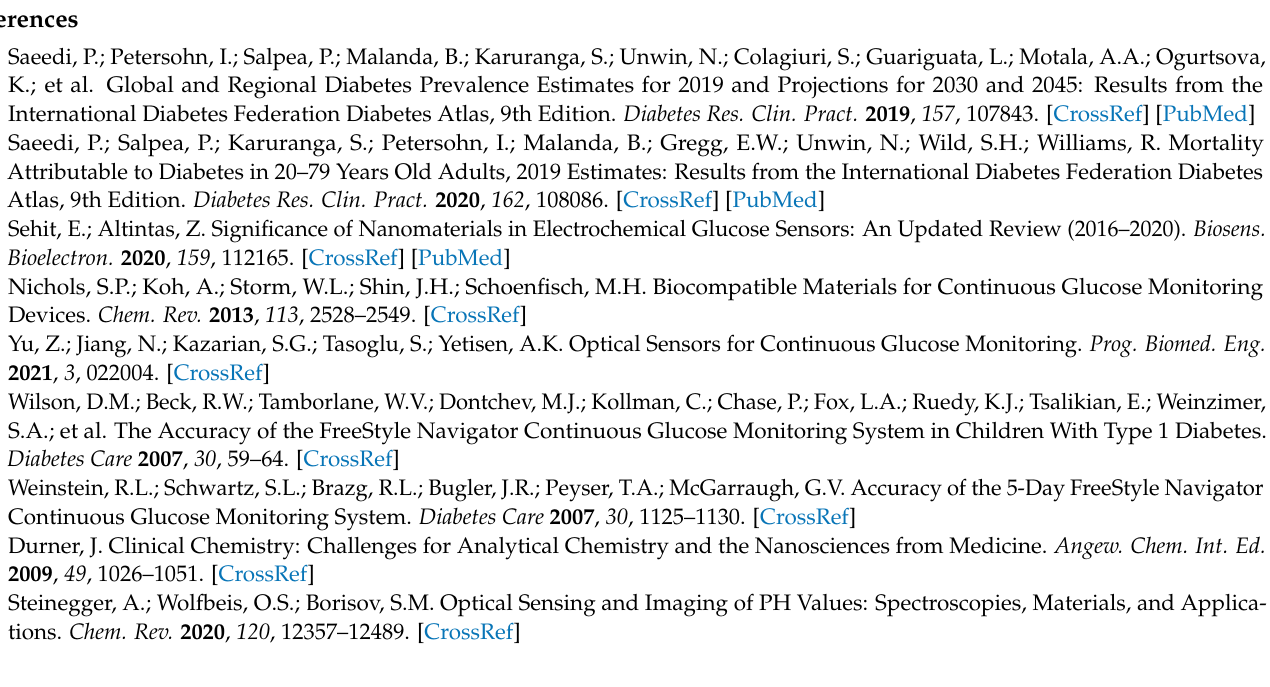
hydrogel the optical fiber; Figure S2. Excitation independence of CdTe QDs; Figure S3. Absorption spectra of fluorescein derivative in different pH; Figure S4. Excitation independence of fluorescein derivative; Figure S5. Diameter changes of the hydrogel fiber in different pH. Error bars are based on standard deviations (n = 3); Figure S6. The pH sensor was stable under long time illumination; Figure S7. Diameter of the hydrogel fiber changes with glucose concentration. Error bars are based on standard deviations (n = 3); Figure S8. pH response of QDs from 3–10. Error bars are based on standard deviations (n = 3); Figure S9. Time response of the sensor in glucose, fructose and lactate. The dots represent the fluorescence intensity recorded every 5 minutes. Error bars are based on standard deviations (n = 3); Figure S10. pH response of the sensor for glucose detection; Figure S11. Detction curves of the sensor in different pH. Error bars are based on standard deviations (n = 3); Figure S12. Fluorescence spectra of the sensor at pH 6.6, 7.4, 7.8 with 10 mM glucose; Figure S13. Fluorescence spectra of the sensor at pH 7.4 with 1 and 10 mM glucose; Scheme S1. Synthesis of fluorescein derivative; Scheme S2. Synthetic scheme of PAM-co-PEG-3-APBA; Scheme S3. Synthetic scheme of amino hydrogel; Scheme S4. Synthetic scheme of fluorescein derivative functionalized